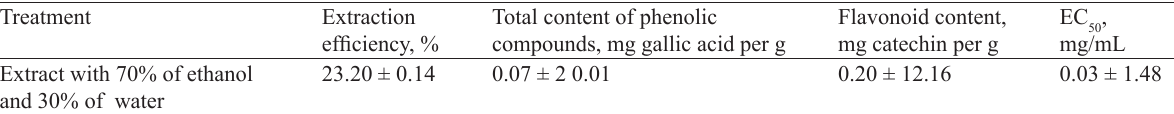
properties of caper extract 50 Total content of phenolic efficiency, %